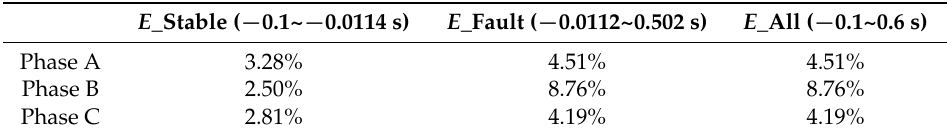
Table 3. Accuracy evaluation results of case II.